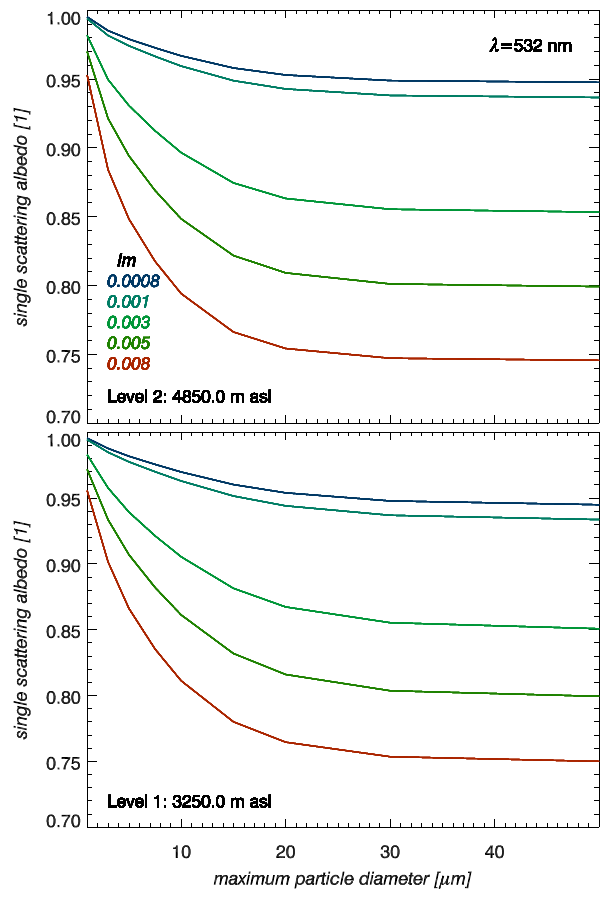
Fig. 6. The same as in Fig. 4, but for the single wavelength of 532nm and as a function of the maximum particle diameter D e , max between 1 and 50µm. The coloured curves represent various values of the size-constant imaginary part (“Im”) of the complex refractive index. For the real part a size-constant value of 1 . 56 was applied (Otto et al., 2009).